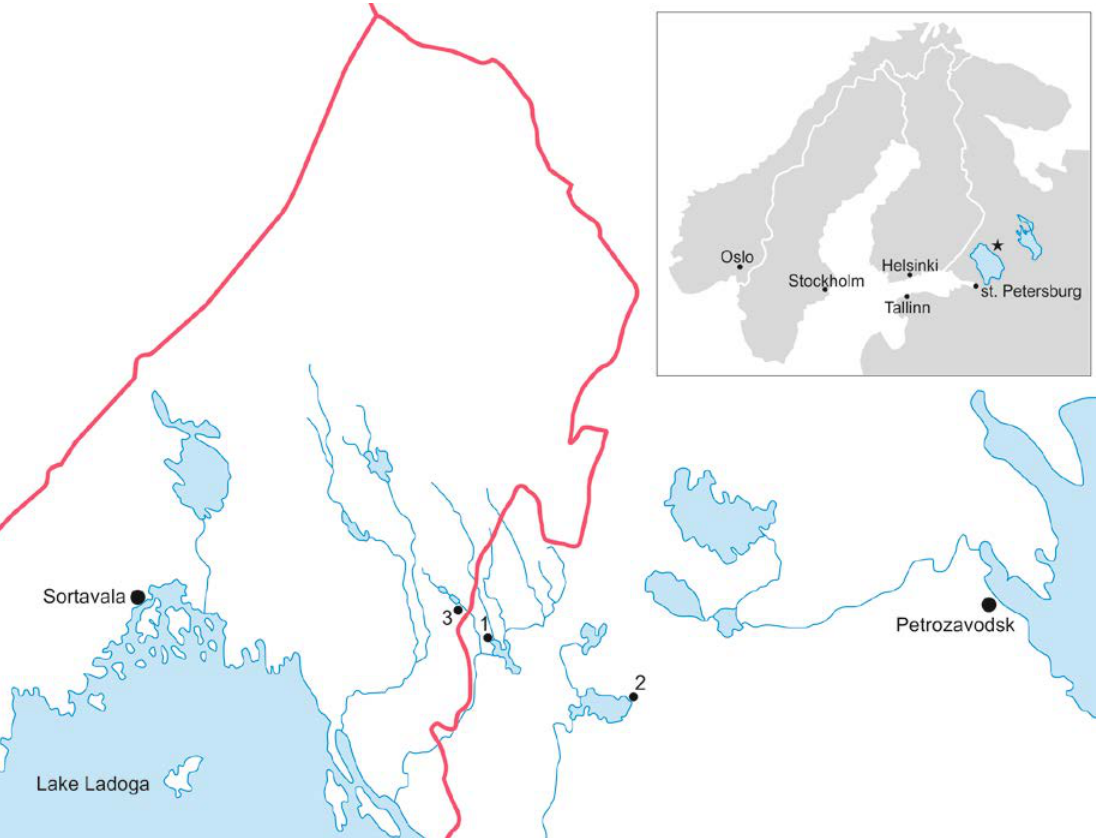
Figure 1. Locations of the studied areas. 1: Kolatselkä; 2: Vieljärvi; 3: Hiisjärvi. The western red line indicates the present state boundary, and the eastern red line the boundary before the Second World War.